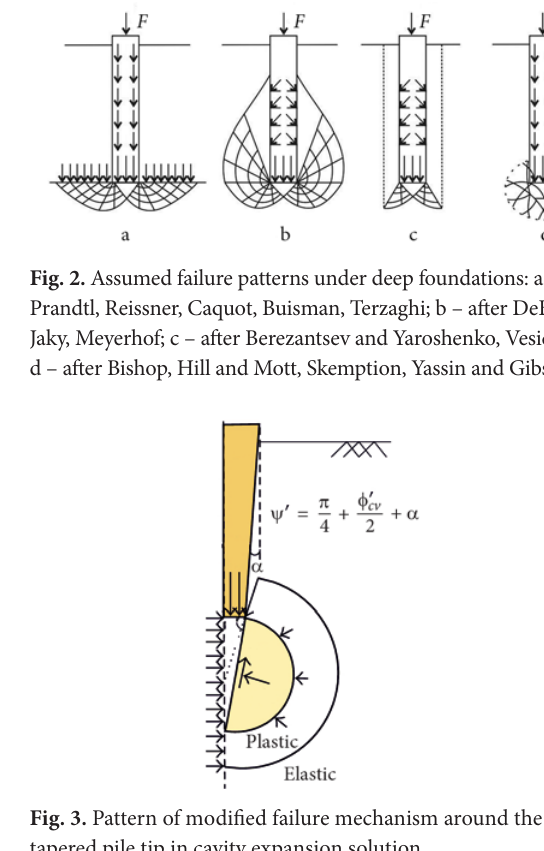
fig. 1. Transmission of vertical load